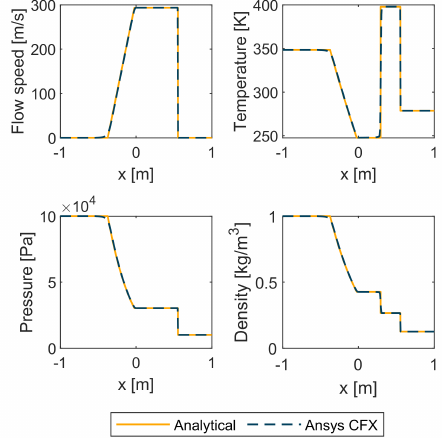
Figure 5. Comparison between the analytical and Ansys CFX solution at t = 0.001 s for the Sod shock tube